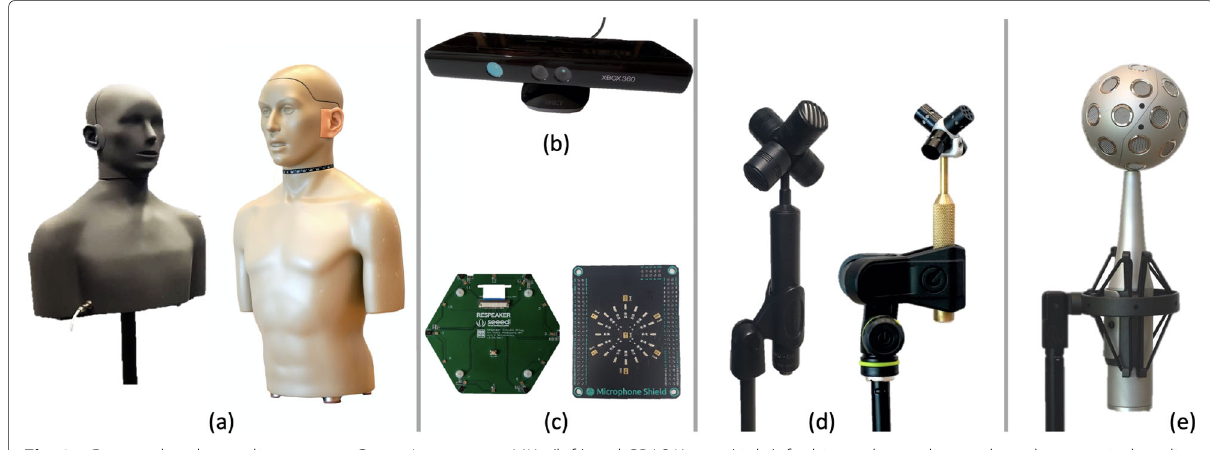
Fig. 2 a Dummy head recording systems Cortex Instruments MK1 (left) and GRAS Kemar (right), for binaural recording and psychoacoustical studies. b A consumer human-computer interaction device (Microsoft Kinect) equipped with a 4-channel linear microphone array. c Example on-board circular arrays employing MEMS microphones, the 6-channel ReSpeaker Circular Array (left) and the 7-channel MOJO Microphone shield (right). d Example tetrahedral arrays, the Rode Soundfield SPS200 (left) and Coresound Tetramic (right) for capturing first-order Ambisonics. e A high-resolution spherical microphone array, the 32-channel mh Acoustics Eigenmike